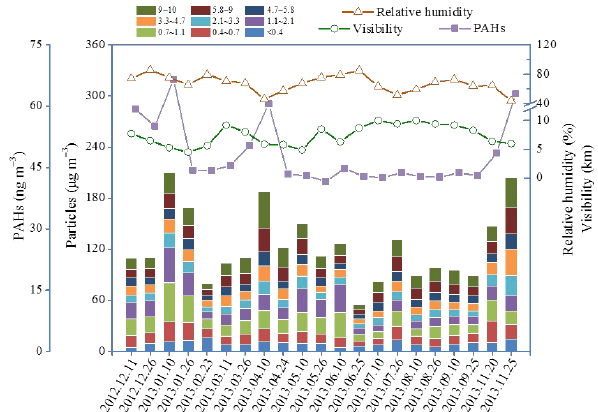
Figure 1. The sampling time series of PAH concentration (ngm − 3 ) , size-segregated particles (µgm − 3 ), temperature ( ◦ C), visibility (km), and relative humidity (%).